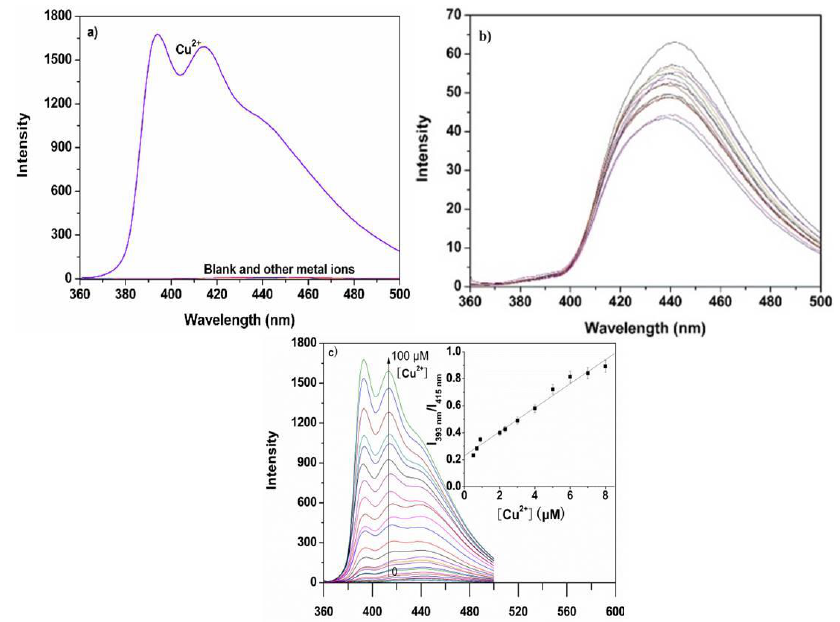
Figure 3. Fluorescence spectra. ( a ) fluorescence response of P (10 µ M) to different metal ions (100 µ M) in alcohol–aqueous media ( v / v , 8:2, pH 6.3, 0.02 M HEPES); ( b ) fluorescence emission of P1 (10 µ M) for above- mentioned metal ions (100 μM) in alcohol– aqueous media ( v / v , 8:2, pH 6.3, 0.02 M emission intensity (I 393nm /I 415nm ) of P (10 μM) as a function of [Cu 2+ ] within 0.5 –8 μM.